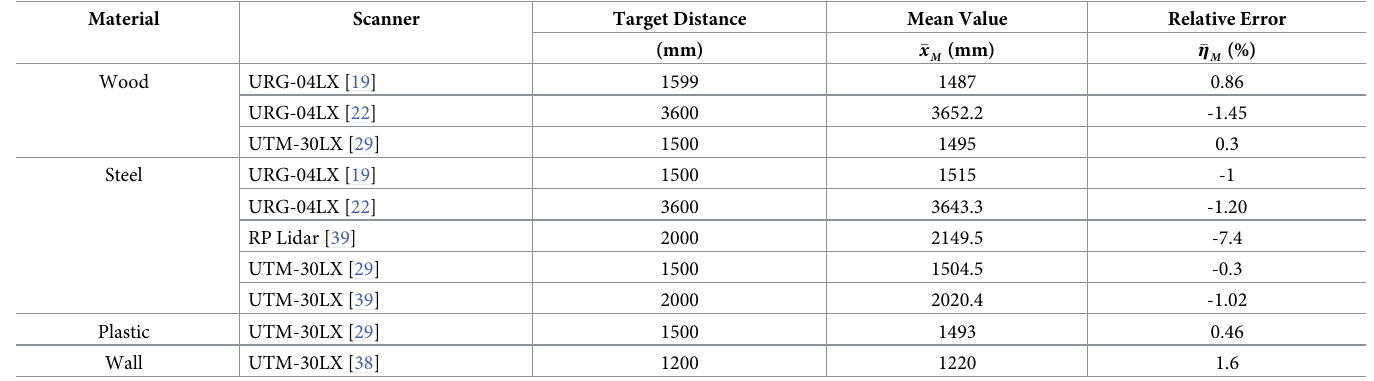
Table 7. Comparison of effect of materials on range measurements.